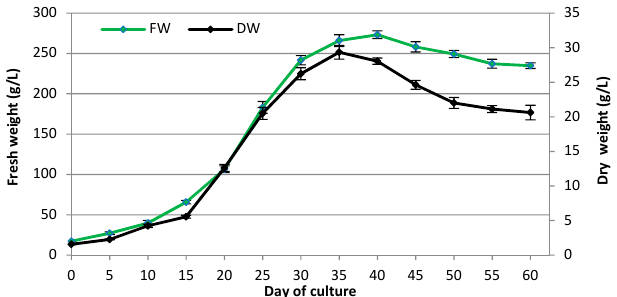
Figure 10. The changes of fresh and dry weight (g L − 1 ) during the growth cycle of R. carthamoides transformed roots cultured for 60 days in 50 mL of liquid WPM medium supplemented with 3% sucrose in a 300 mL Erlenmeyer flask, in light conditions (16/8-h light/dark photoperiod) on a rotary shaker at 80 rpm. The results are means values ± SE of nine replicates for each time point of the growth